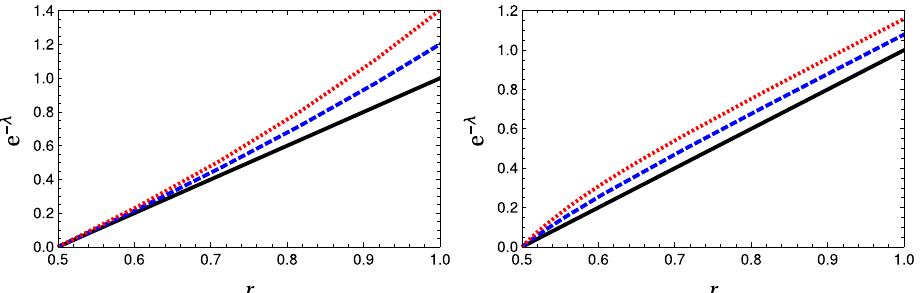
Fig. 3 Left panel: Metric function e − λ vs radial coordinate r for the particular constraint # 1 assuming different values of the parameter α . Right panel: Metric function e − λ vs radial coordinate r for different values of the parameter α for the particular constraint # 2 assuming